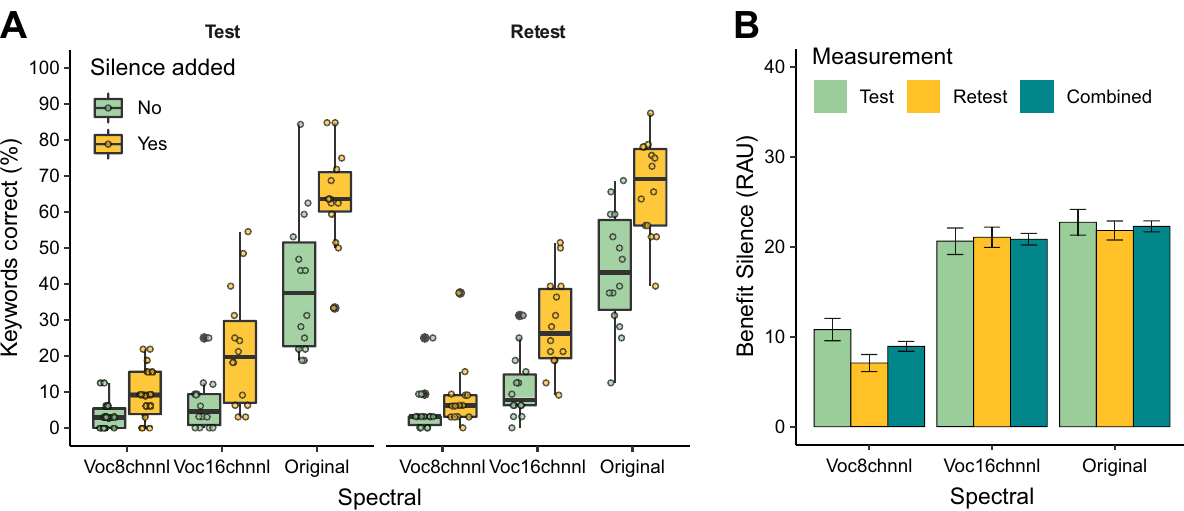
Figure 2. ( A ) Effect of spectral content, addition of silences, and measurement (test and retest) on the percentage of correct recalled keywords. ( B ) The benefit (based on the RAU scores) on intelligibility when adding the 100 ms silence segments between the syllables of the TC sentences for the different spectral conditions. Error bars show the standard